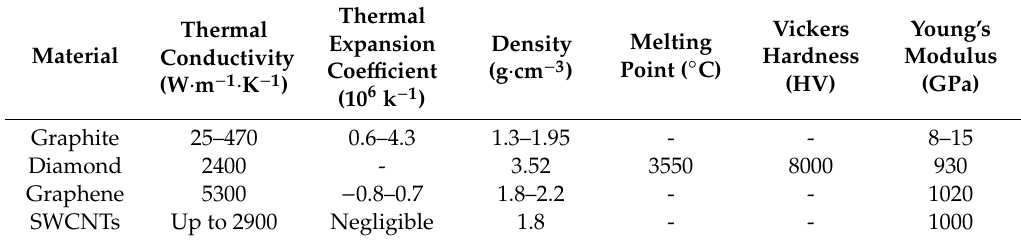
Table 3. The features of common carbonaceous reinforcements